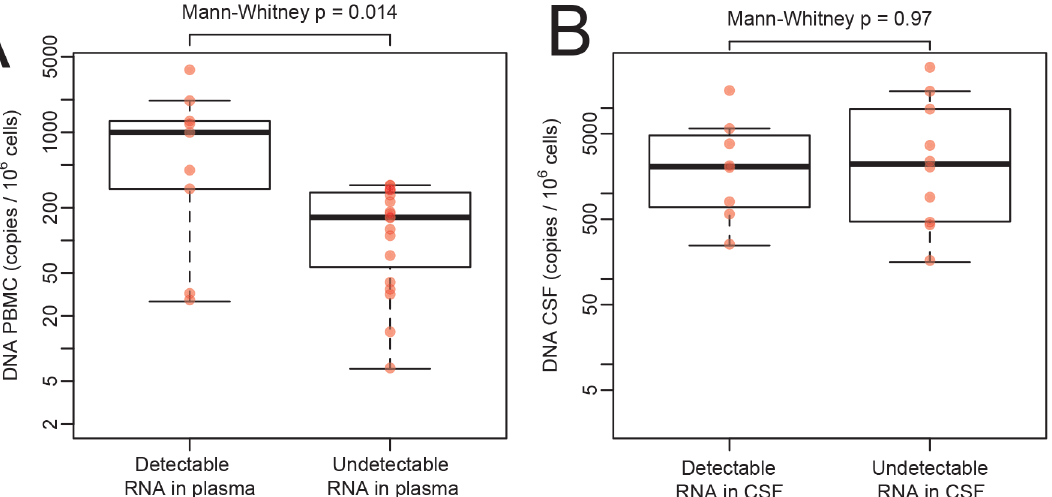
Fig 3. HIV DNA levels in PBMC and CSF cells between HIV RNA-suppressed and non-suppressed subjects. Comparison of HIV DNA levels in PBMC (A) and CSF pellet (B) between individuals with detectable and undetectable HIV RNA levels in blood plasma or CSF supernatant, respectively. Rank-based Mann-Whitney test p values are